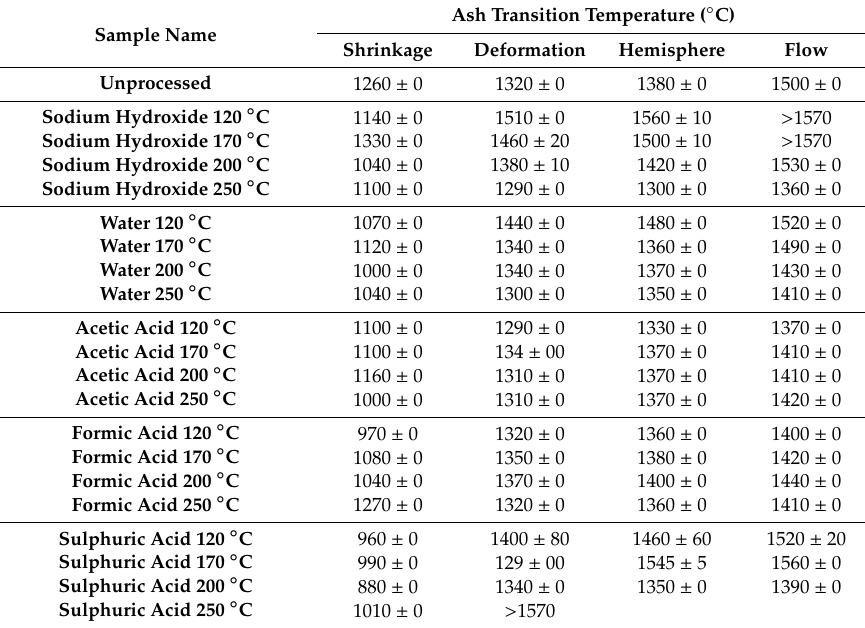
Table 6. Ash transition temperatures from the ash fusion